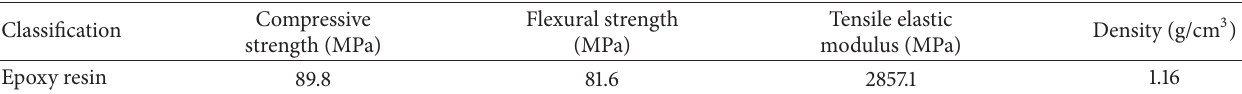
Table 3: The material properties of the epoxy resin used in this